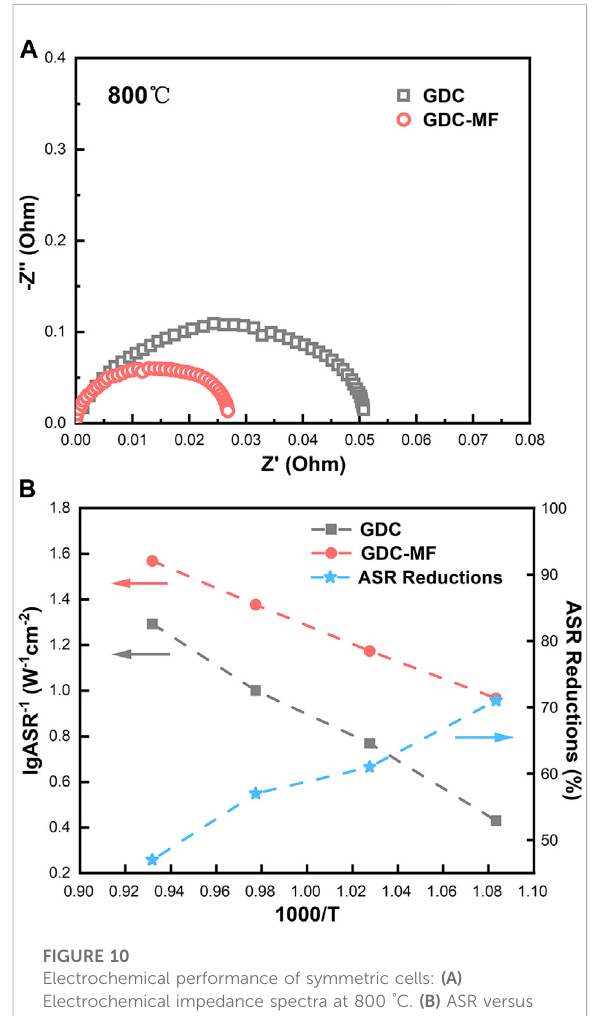
FIGURE 10 Electrochemical performance of symmetric cells: (A) Electrochemical impedance spectra at 800 ° C. (B) ASR versus temperature curves of LSCF cathodes on GDC and LSCF cathodes on GDC-MF (left Y -axis), and percentage reduction of ASR of LSCF cathodes on GDC-MF relative to GDC (right Y -axis).